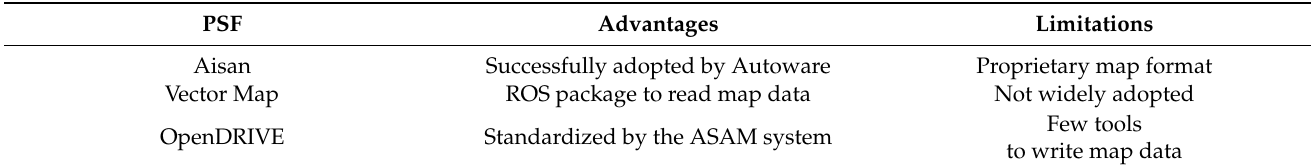
Table 4. Comparison between Aisan vector map and major PSFs for use in Autoware (adapted from